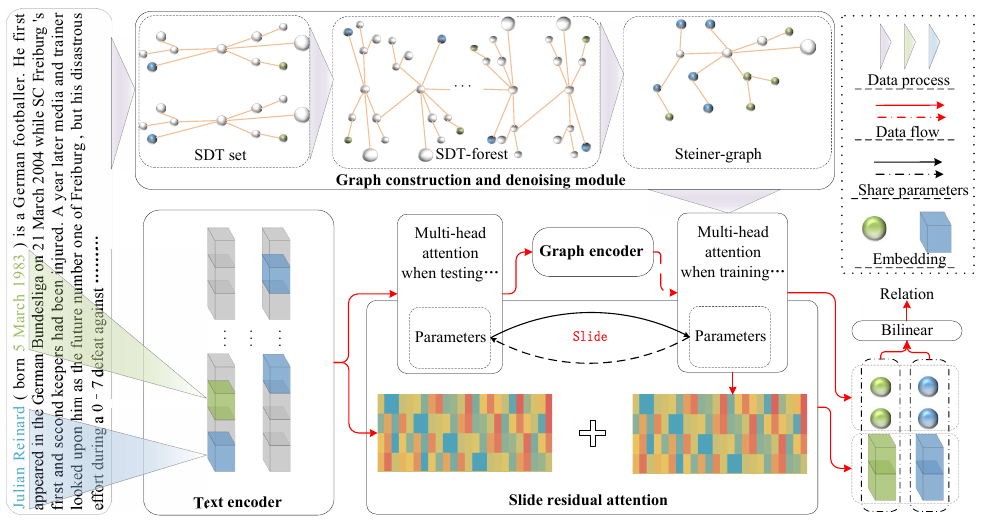
Fig. 2 Framework of DGI